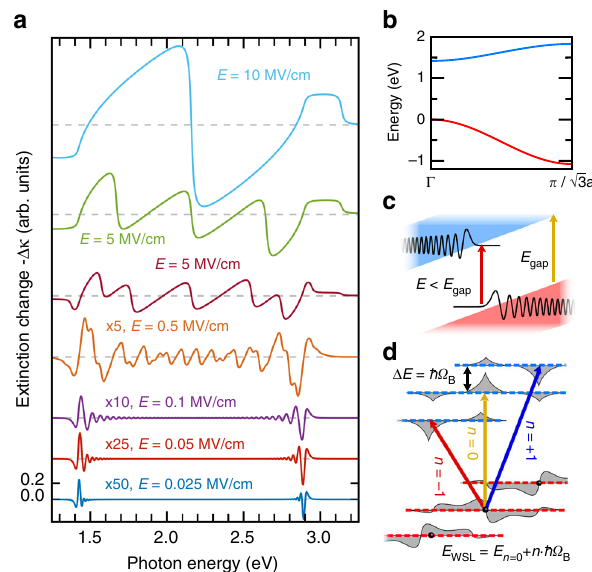
side of Fig. 2c, respectively. Note that Δ T / T between 2.5 eV and